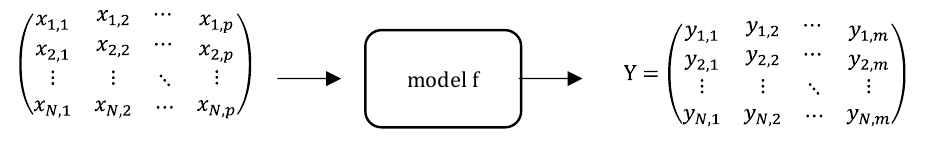
Figure 3. Sampling phase and notations.